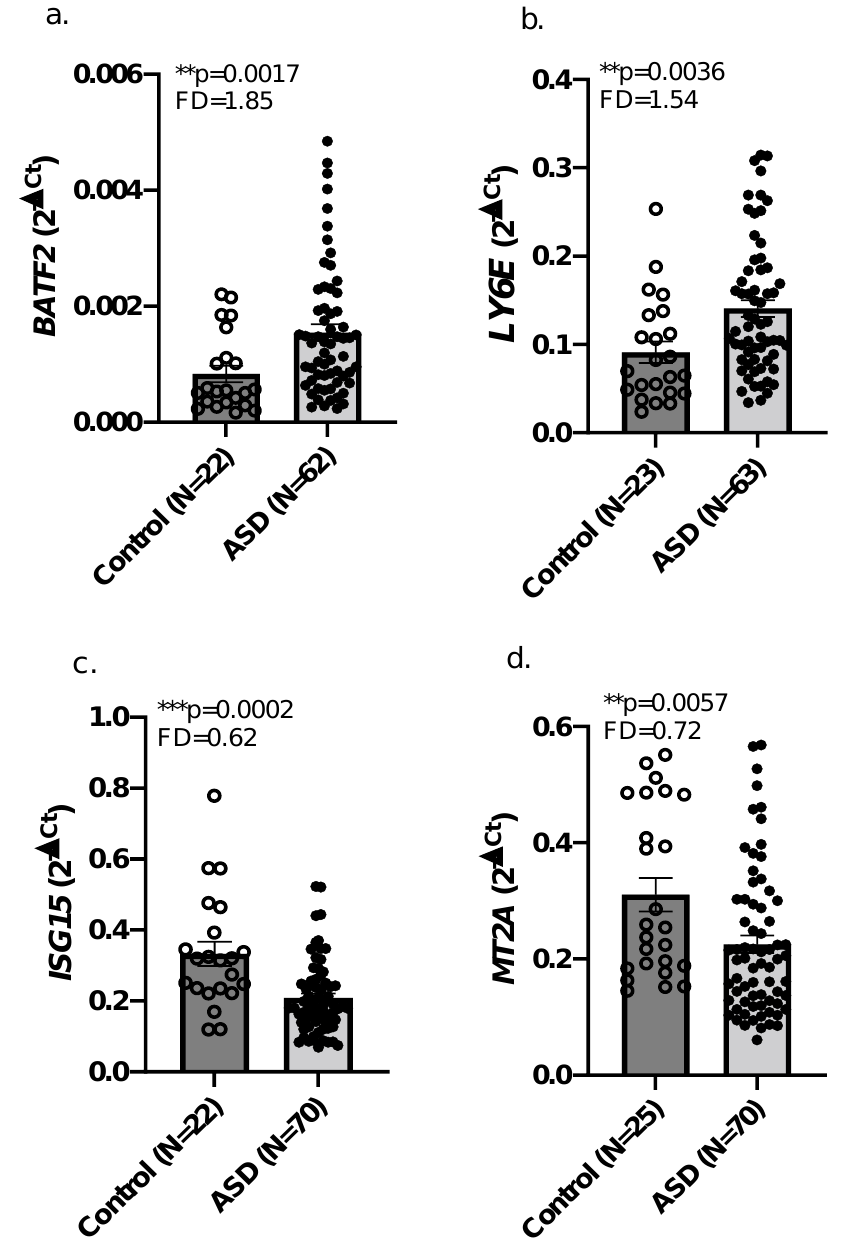
Figure 1. Real-time qPCR validation for RNA expression levels in Israeli and American whole blood samples from ASD and control children. Box plots show mRNA levels in whole blood samples for ASD vs. neurotypical control (mean ± SEM) for the following genes: ( a ) BATF2 ; ( b ) LY6E ; ( c ) ISG15 ; ( d ) MT2A . Outliers were removed, and analysis was conducted using a non-parametric Mann–Whitney test. FD and p values are shown for the genes with differential expression in ASD vs. neurotypical controls. FD, fold difference (ASD vs. controls). ** p < 0.01; *** p < 0.001.